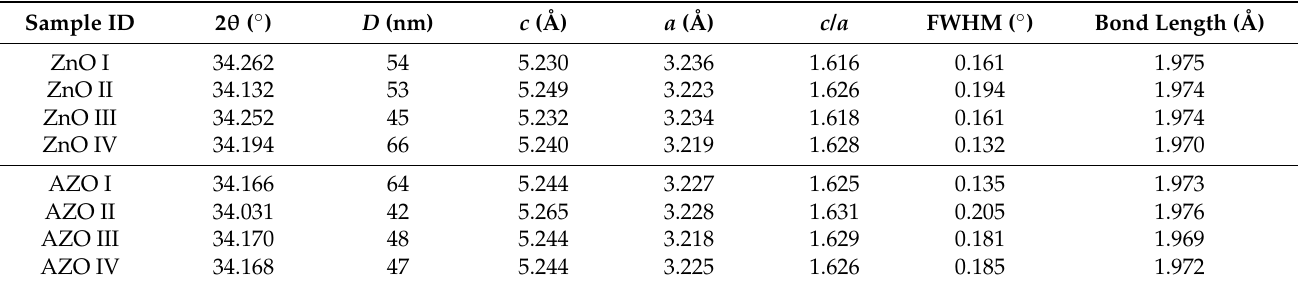
Table 2. Crystalline properties of ZnO and AZO samples from XRD